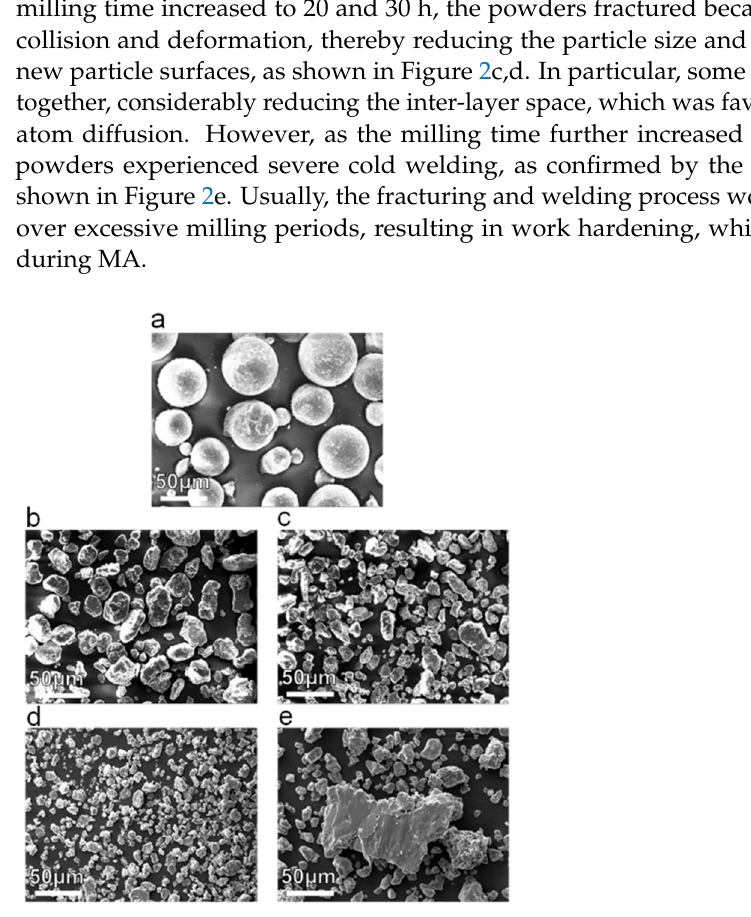
Figure 2. SEM morphologies of ( a ) initial mixed powders and ( b – e ) mixed powders after milling for 10, 20, 30, and 40 h, respectively.